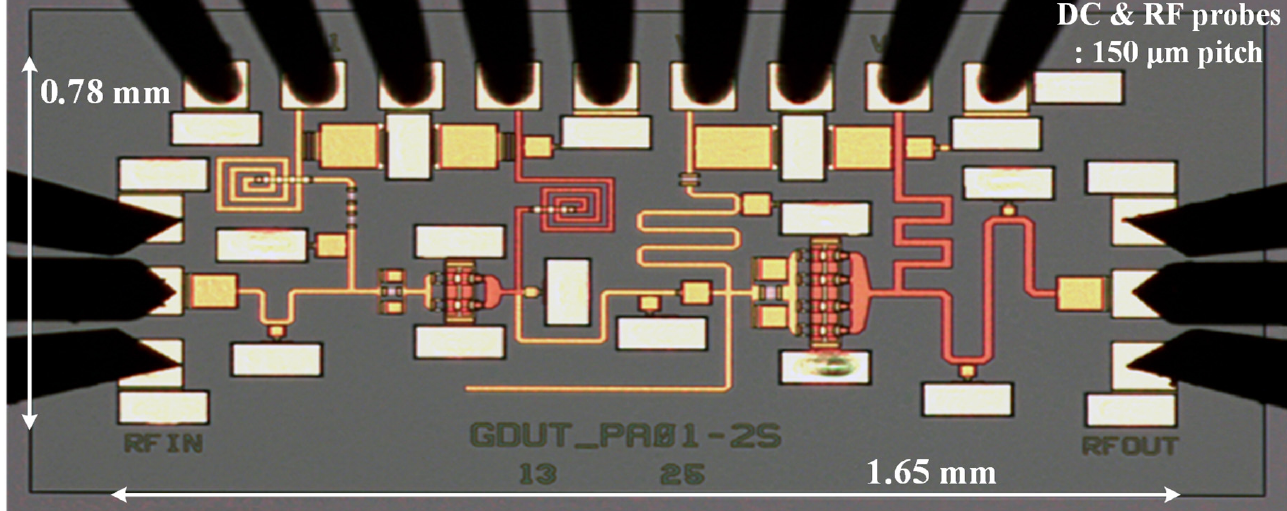
Figure 21. Micrograph of the 24–30 GHz GaN MMIC DA together with DC and GSG-type RF probe card tips.